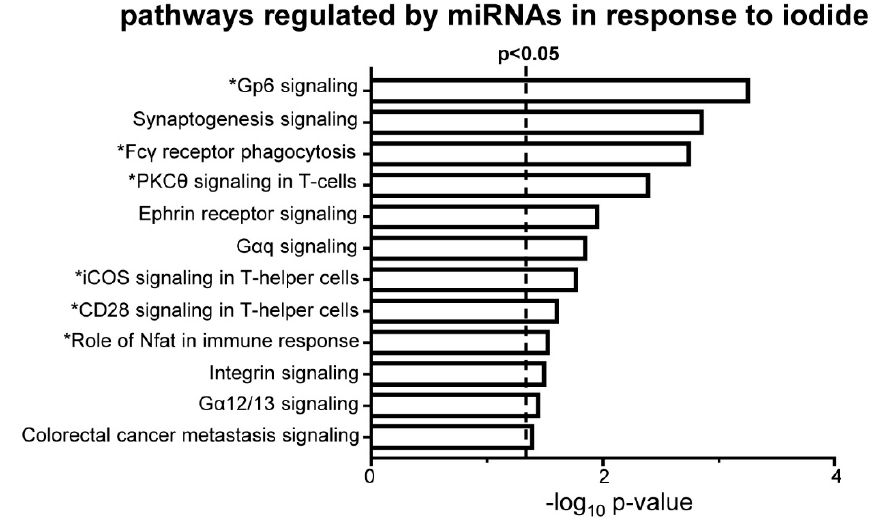
Figure 9. Enriched canonical pathways of mRNAs that are differentially expressed after iodide treatment (WTI/WTC, ≥ 1.5-fold change and p < 0.05) and are regulated by miRNAs that are also differentially expressed in the same samples. Analysis was performed using IPA with absolute z -score set at ≥ 1.5 and p < 0.05. White bars indicate upregulated pathways. Pathways marked with an asterisk (*) refer to processes relevant to inflammation/autoimmunity.